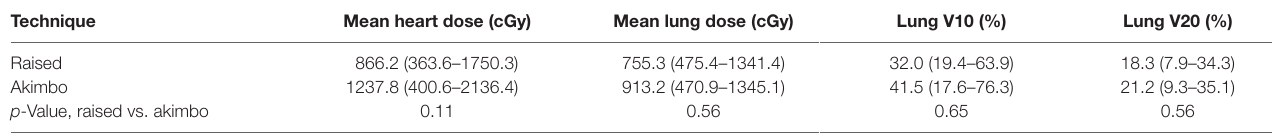
TaBle 4 | cardiopulmonary dosimetry in relation to arm